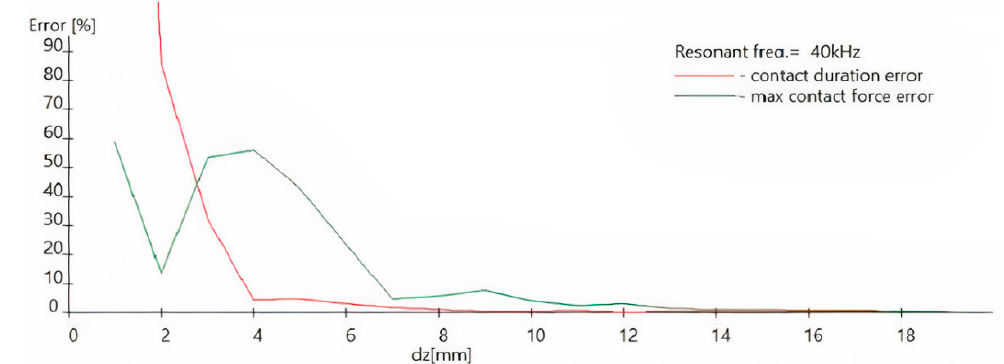
Figure 12. The error course of the contact time (red line) and the maximum impact force (green line) depending on grain diameter.